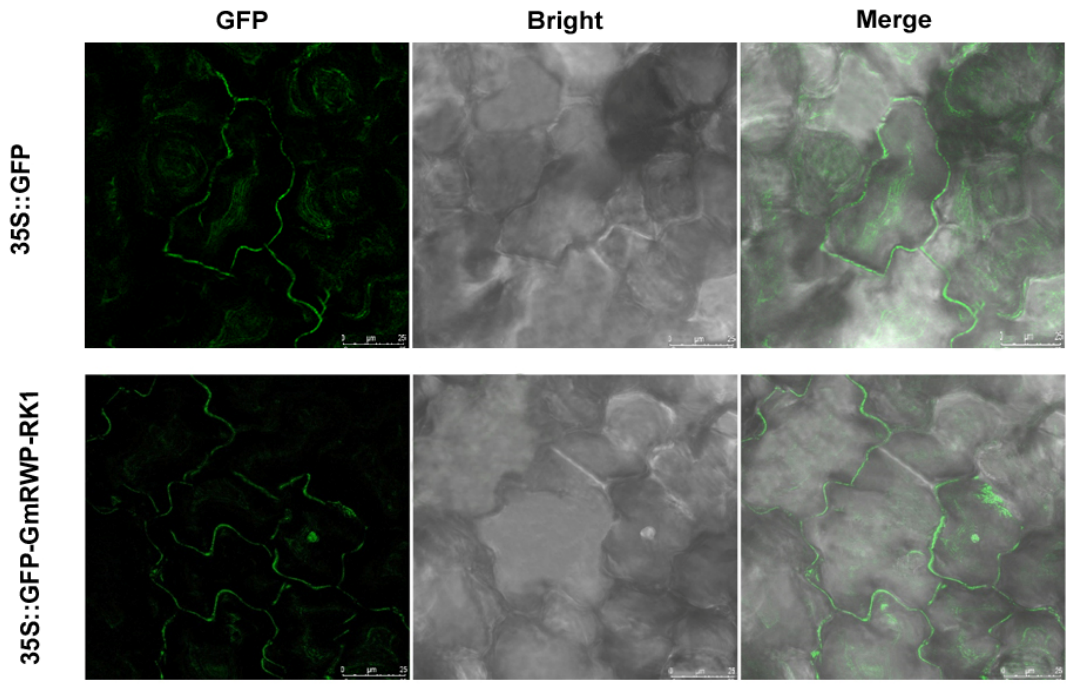
Figure 11. Subcellular localization of GmRWP-RK1 using the transient expression in Nicotiana benthamiana . The vector containing 35S-GFP alone was used as a control, whereas 35S-GFP-GmRWP-RK1 represents the recombinant vector containing the GmRWP-RK1 construct. Each row begins with a GFP fluorescence, bright field, and merge fluorescence. A confocal laser scanning microscope was used to examine the fluorescence signals (Leica Microsystem CMS, D-68165 Mann ‐ heim).